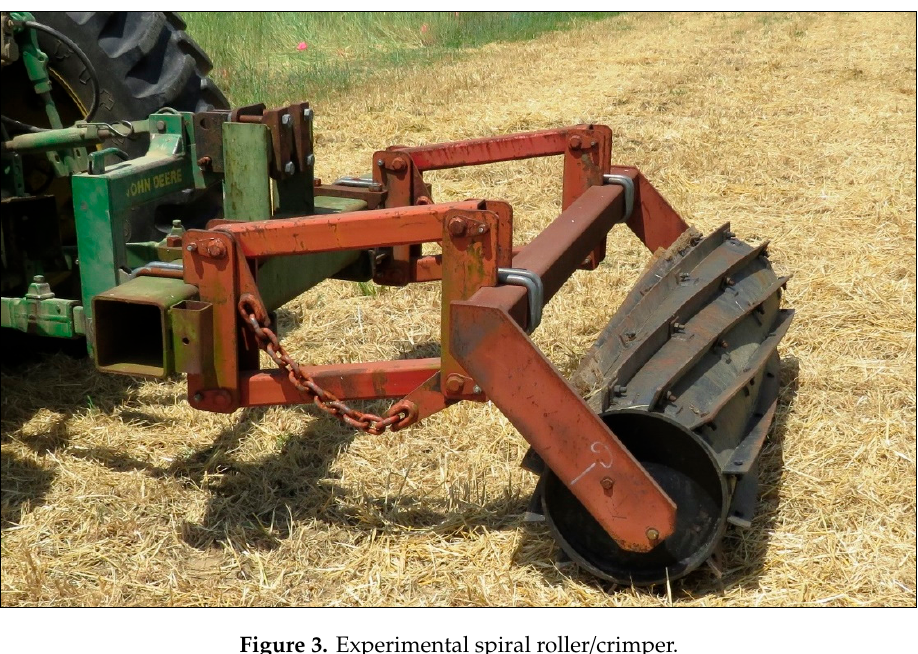
Figure 3. Experimental spiral roller / crimper.